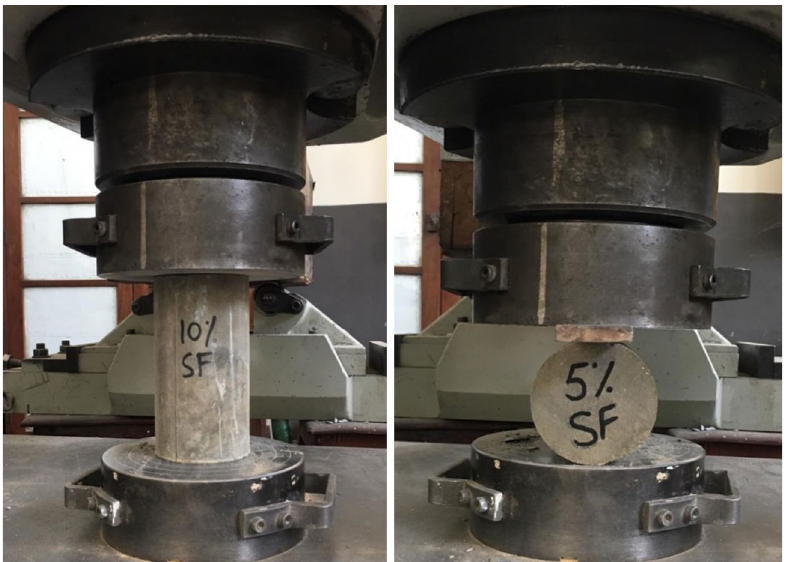
Figure 4. Test setup used to measure the compressive and tensile strength of concrete